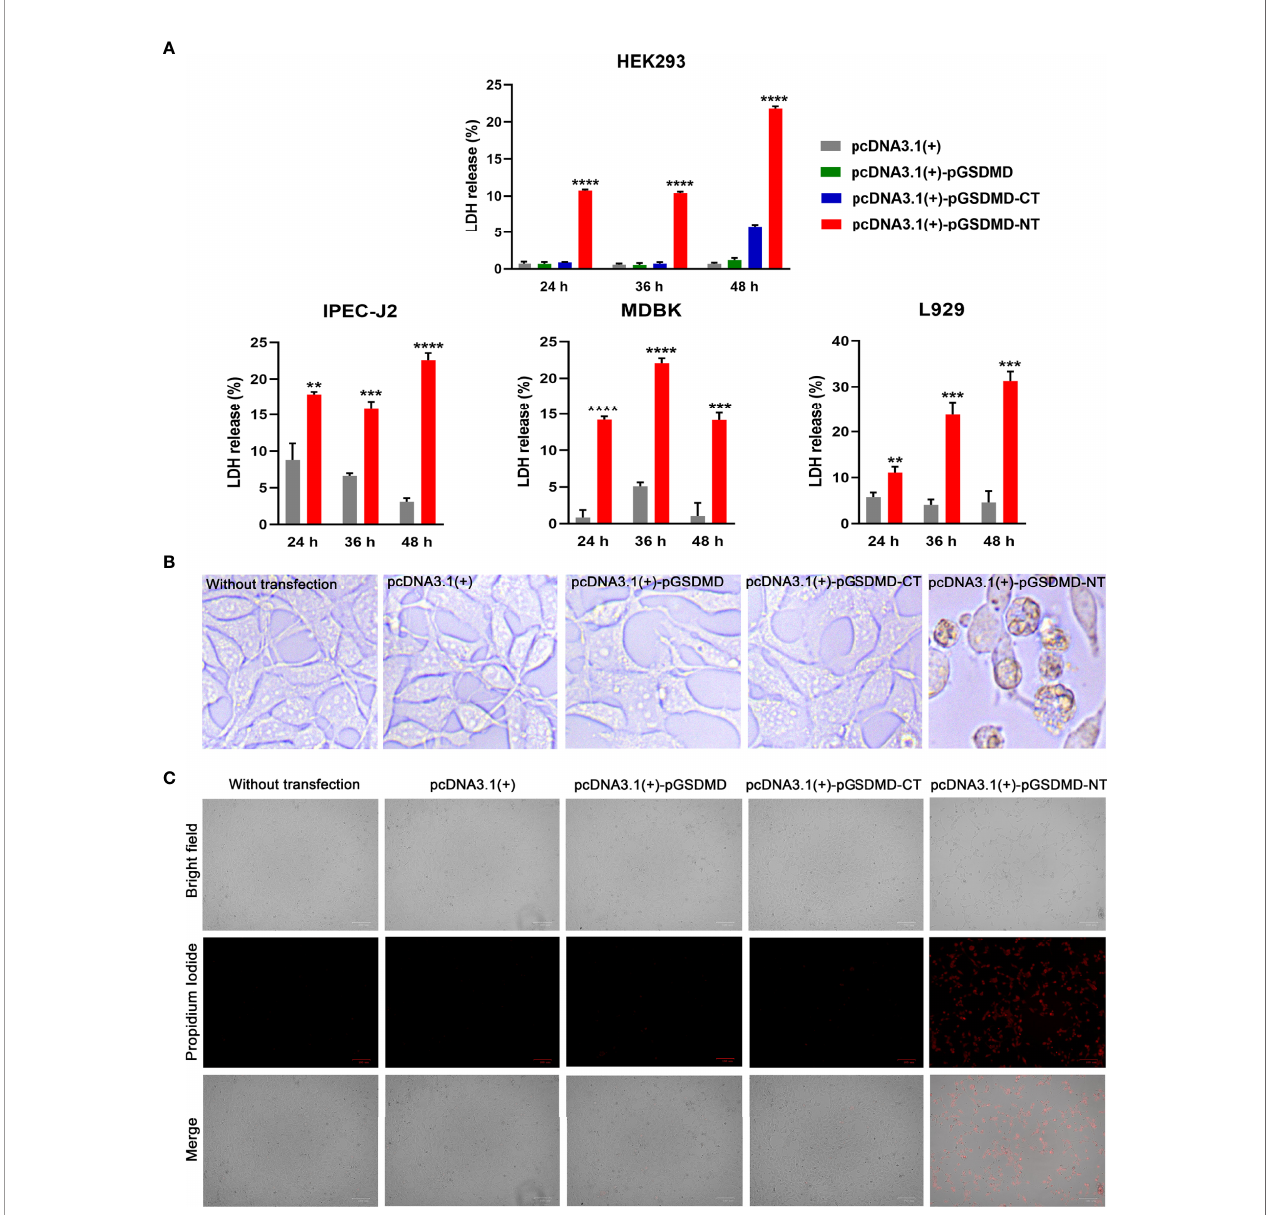
FIGURE 6 | pGSDMD-NT caused cell membrane damage. (A) IPEC-J2, HEK293, L929 and MDBK cells were transfected with pcDNA3.1(+)-pGSDMD, pcDNA3.1 (+)-pGSDMD-CT, pcDNA3.1(+)-pGSDMD-NT, or pcDNA3.1(+). The release of LDH was determined at 24, 36 and 48 h. Values are the means of triplicates and shown as means ± SD. ** p < 0.01, *** p < 0.001, **** p < 0.0001. (B) The representative pictures of the HEK293 cells transfected with pcDNA3.1(+)-pGSDMD, pcDNA3.1(+)-pGSDMD-CT, pcDNA3.1(+)-pGSDMD-NT, or pcDNA3.1(+) at 24 h after the transfection. (C) The transfected HEK293 cells were stained with PI and observed under aninverted fl uorescence